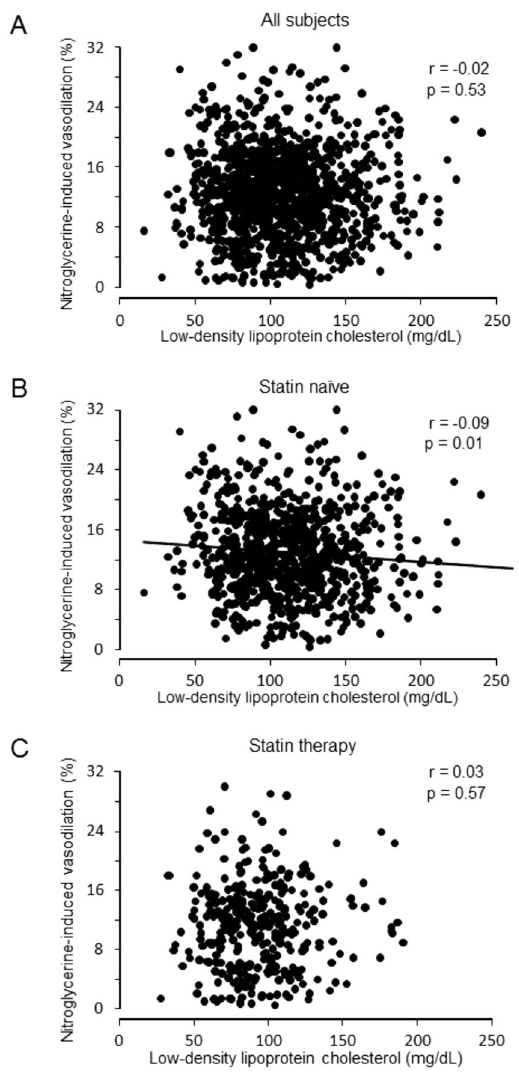
Figure 3. Bar graphs show flow-mediated vasodilation ( A ) and nitroglycerine-induced vasodilation ( B ) in the non-high and high low-density lipoprotein cholesterol group.